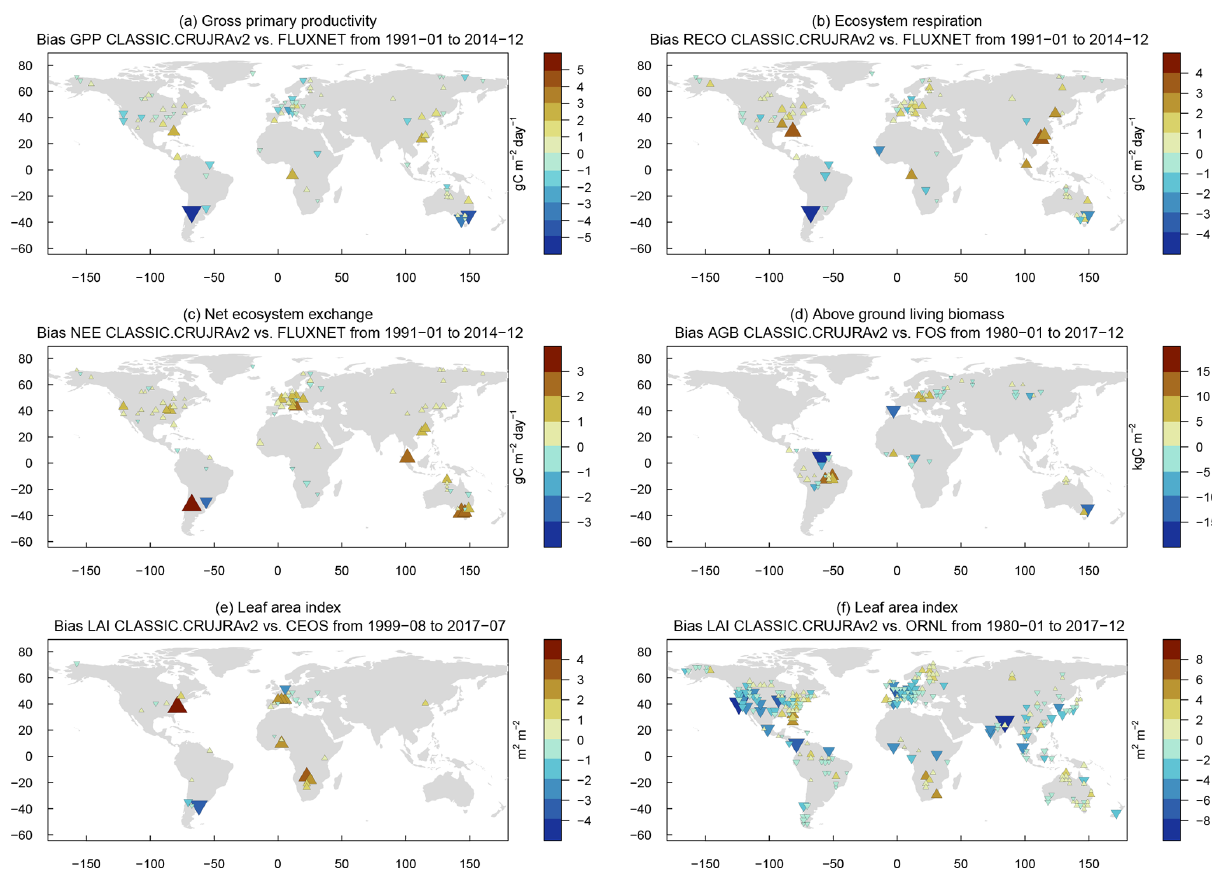
Figure 2. Same as Fig. 1 but for (a) gross primary productivity, (b) ecosystem respiration, (c) net ecosystem exchange, (d) above-ground biomass, (e) leaf area index, and (f) maximum leaf area